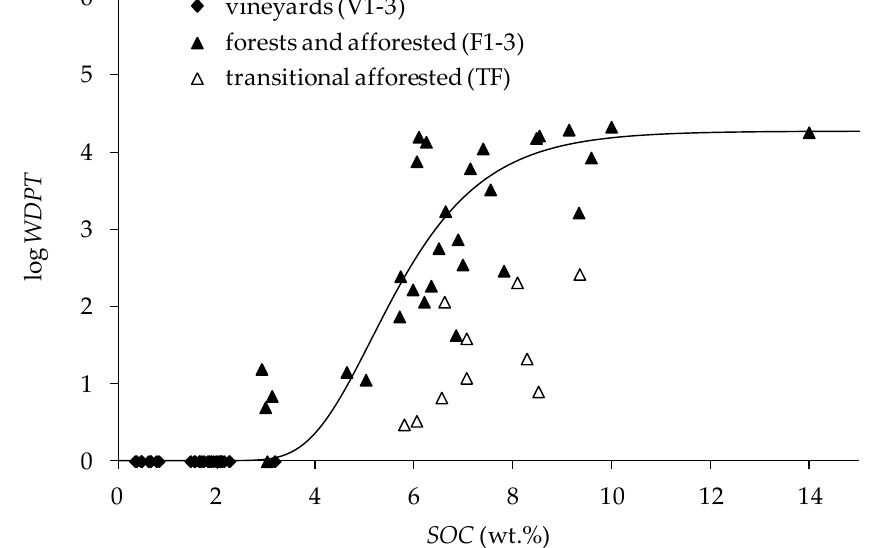
Figure 3. Dependence of persistence of soil water repellency (log water drop penetration time test (WDPT)) on SOC content at the vineyard, forest, and afforested study sites.